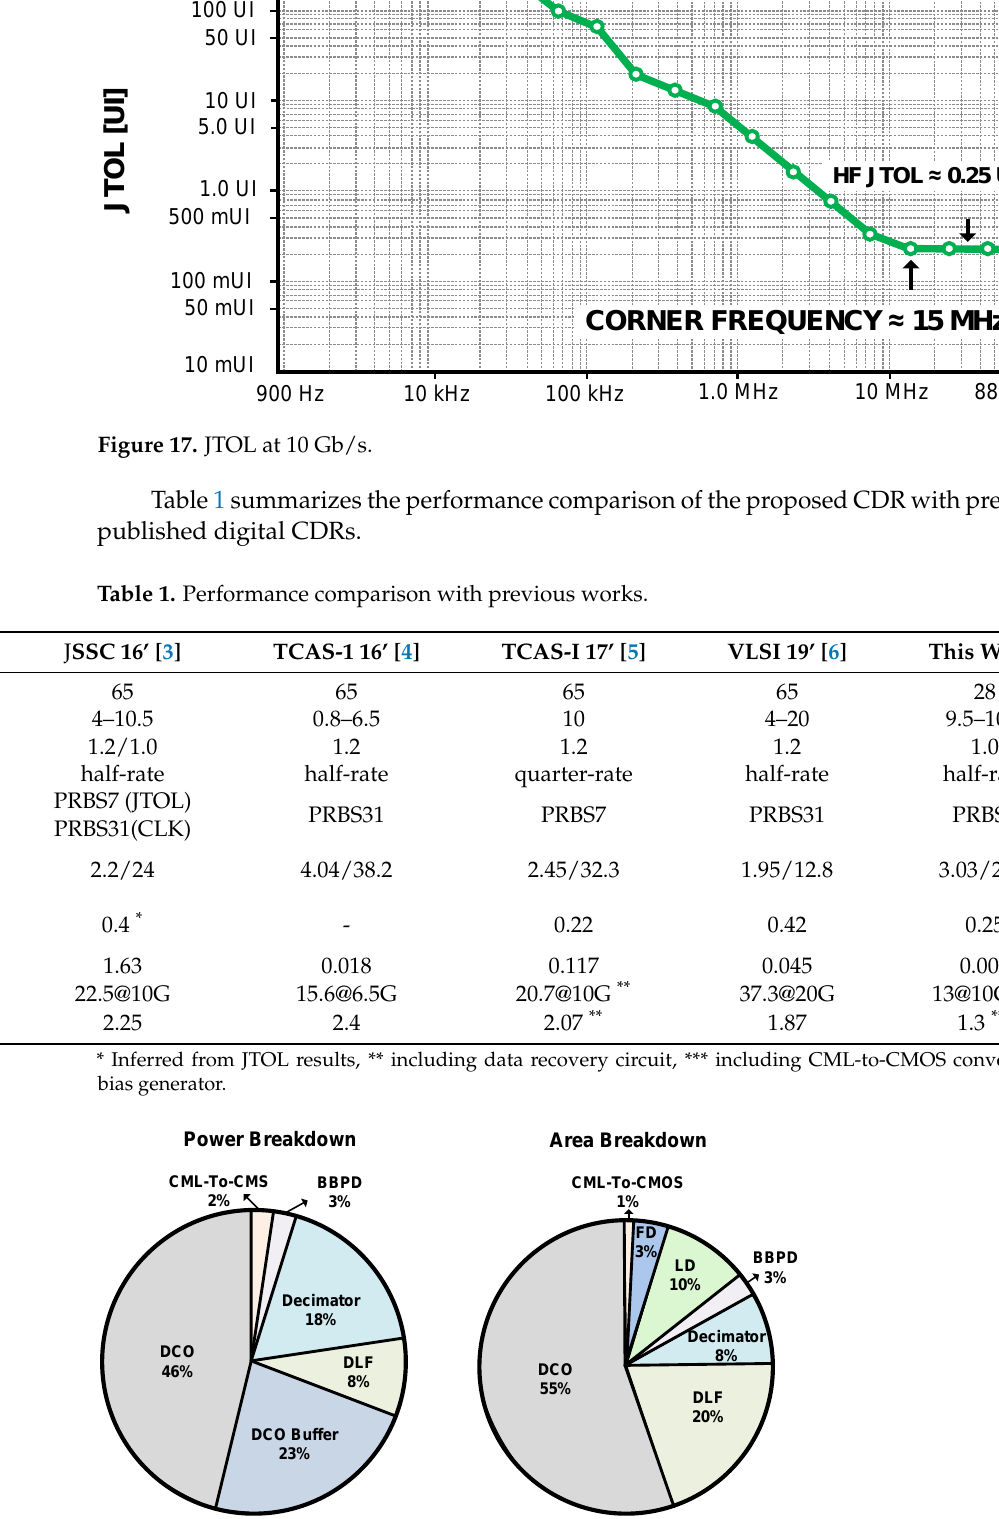
Figure 18. Power and area breakdown of the proposed